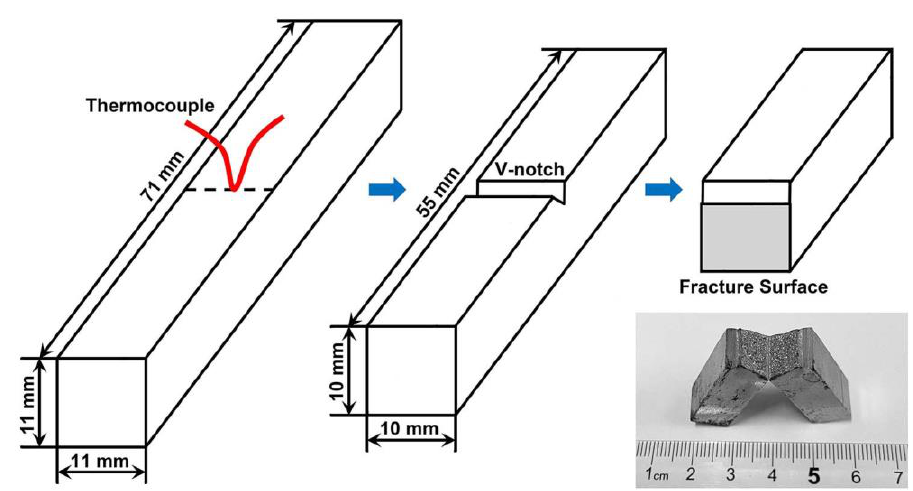
Figure 1. Schematic images of the specimens used for large-heat-input welding simulations and Charpy impact tests.